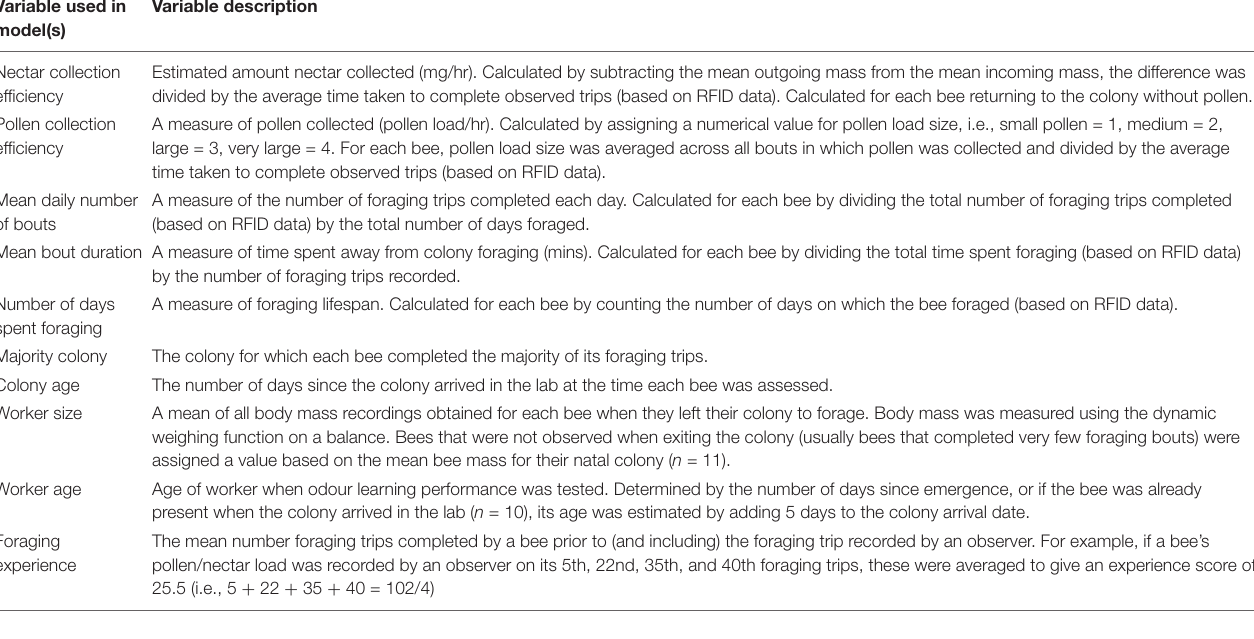
TABLE 1 | Descriptions of the response and predictive variables used in